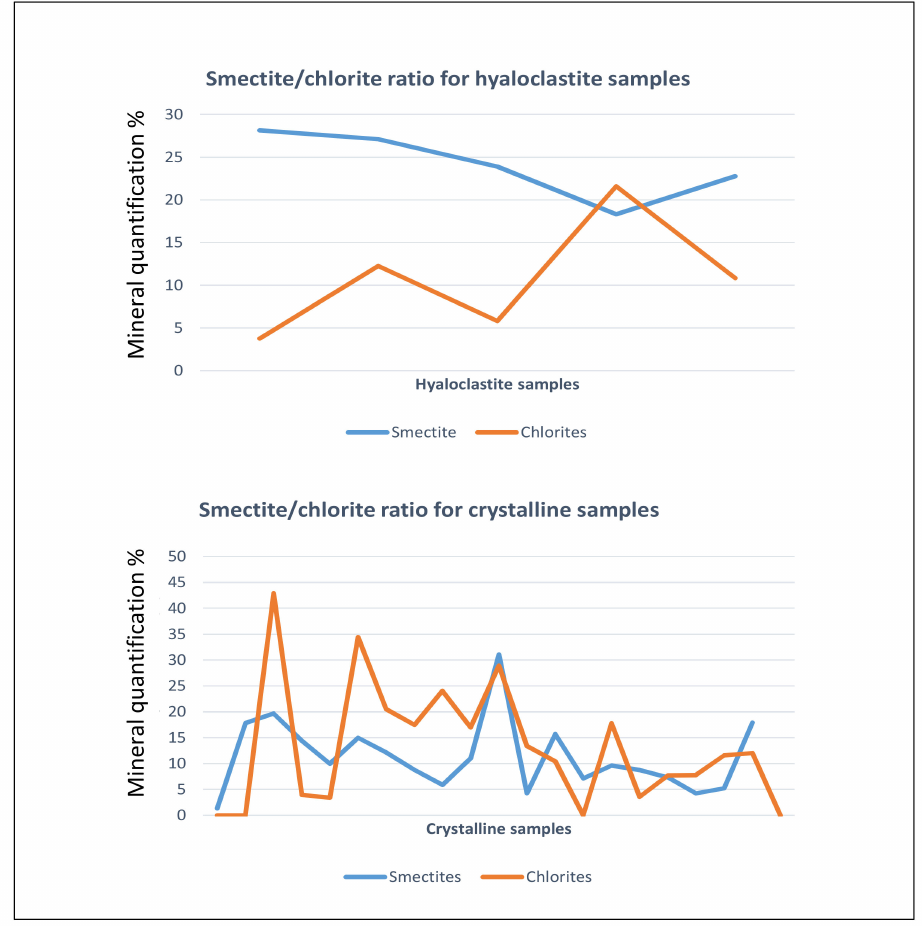
Figure 14. Chlorite and smectite quantification (volume percentage) from XRD measurements. X axis: analyzed samples (5 samples for hyaloclastites, 21 samples for crystalline